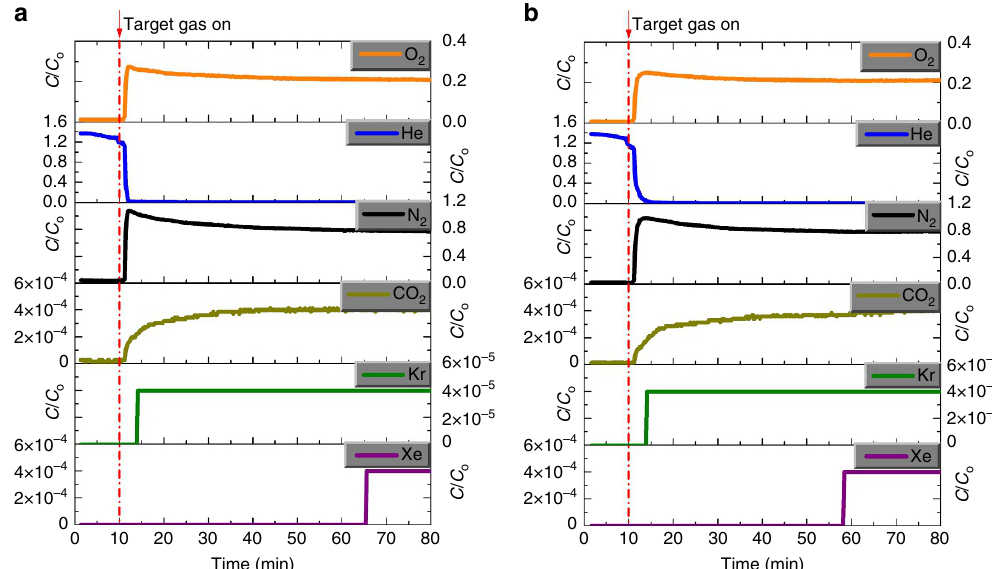
Figure 3 | Single column breakthrough experiments using SBMOF-1 at room temperature and 1 atm. Column is initially purged with He. ( a ) Inlet is a dry gas mixture with 400p.p.m. Xe and 40p.p.m. Kr balanced with air. ( b ) Inlet is the same gas mixture as in ( a ) with 42% relative humidity. Note that the Xe breakthrough time is only marginally decreased in the presence of